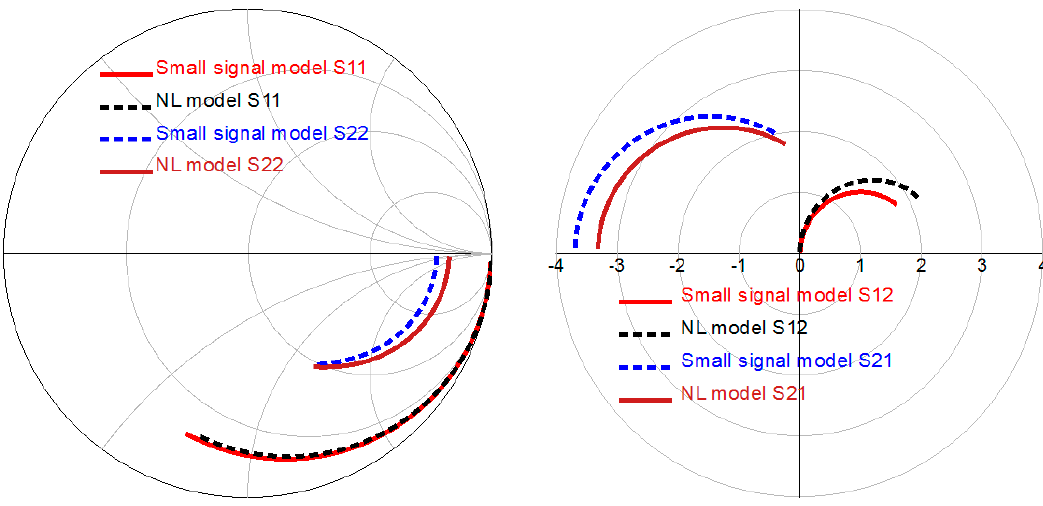
Figure 2. Scattering parameters comparison of linear and NL ED02AH models transistor in frequency range of 0.5 to 30 GHz (V gs = − 0.3 V and V ds = 2 V).